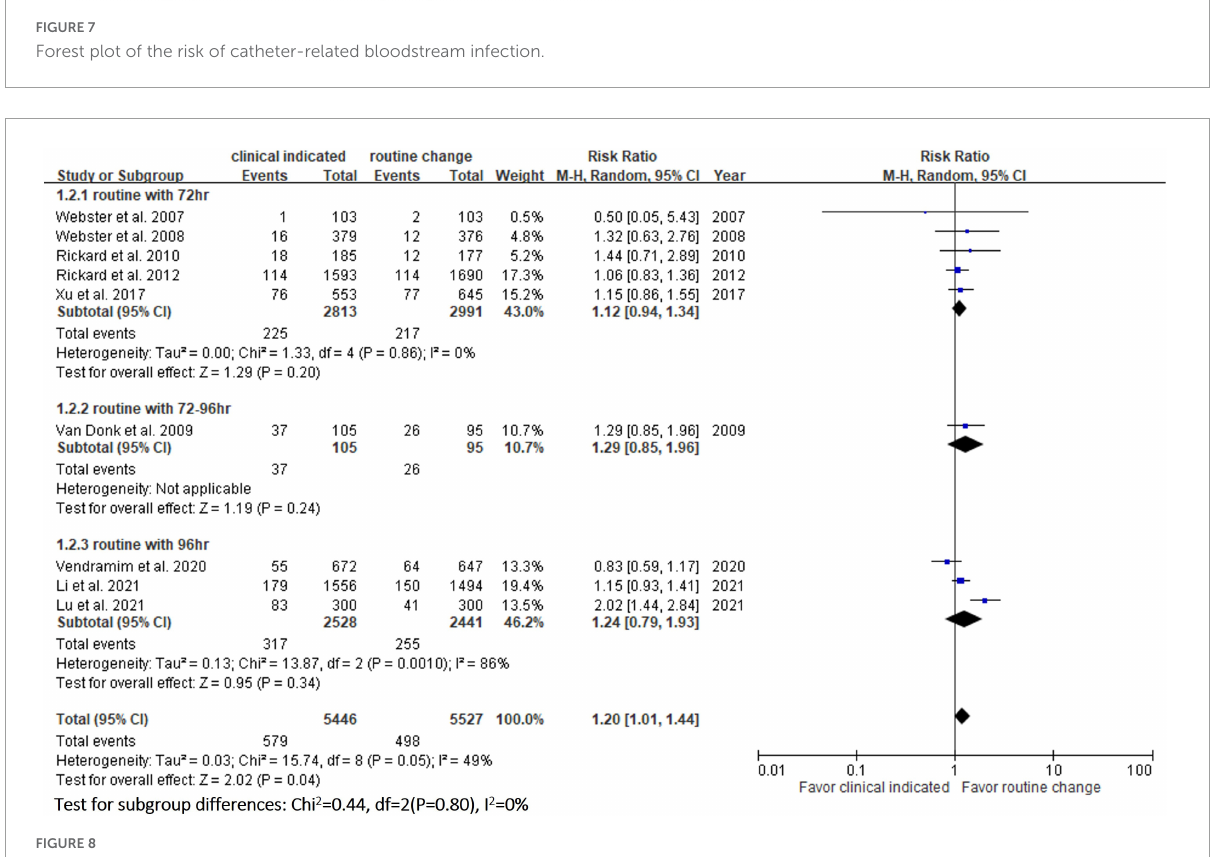
FIGURE8 Forest plot of the risk of accidental